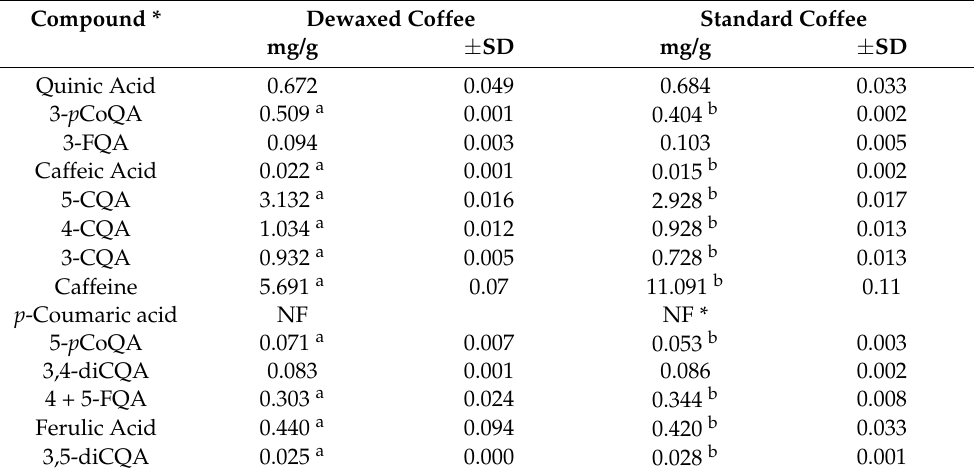
Table 2. Chlorogenic acids and other bioactive compounds ( n = 14) content in standard and dewaxed coffee pods samples. Data are displayed as average value (mg/g) and standard deviation ( ± SD). Compound * Dewaxed Coffee Standard Coffee mg/g ± SD